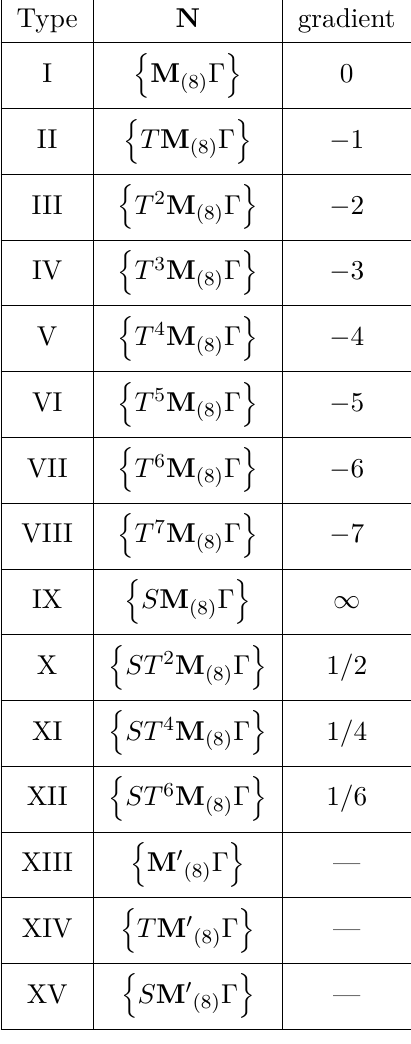
Table 18 . Types for D = 8